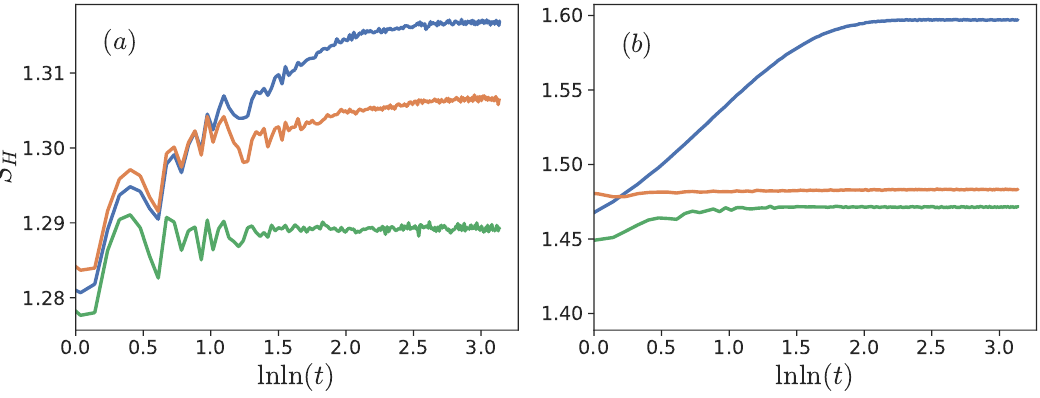
Figure 3: Hartley number entropy for L = 12 and 80000 samples with D = 36 and V = 0.2 (left) and D = 20 and V = 2.0 (right). The largest Hartley number entropies occur in the full model (blue) while the Hartley number entropies quickly saturate in the Anderson case (green). The effective model is in between those two cases (orange).